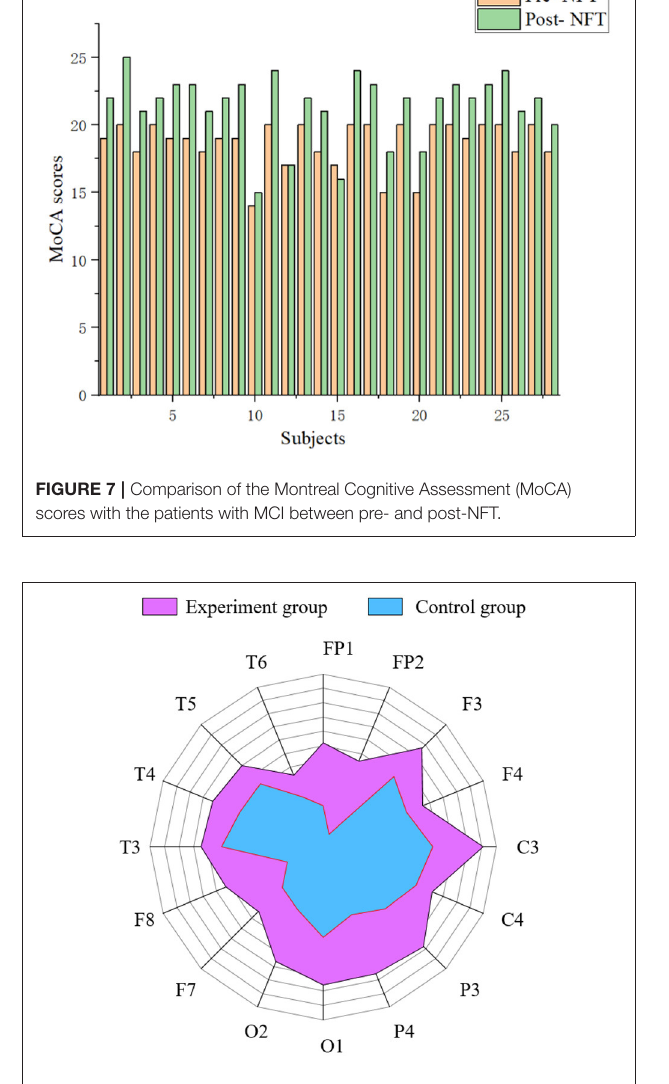
patients with MCI (Kashefpoor et al., 2019). Brain